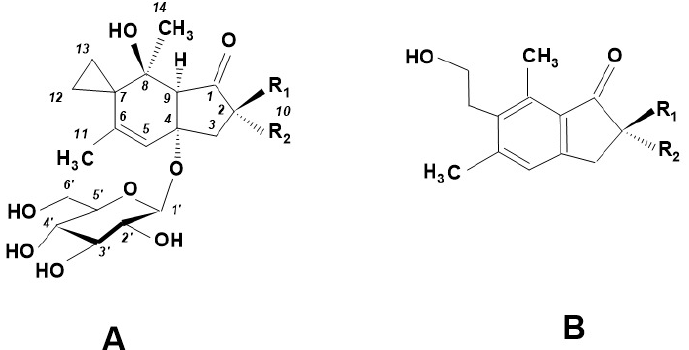
Figure 6. The basic structure of ptaquiloside and its derivatives (PTA, CAU and PTE: A ), and of the pterosins (pterosin G, pterosin A and pterosin B) that can be formed from them ( B ) (based partly on [19]). Table 1. Chemical structure of PTA derivatives (based on [19]). See also Figure